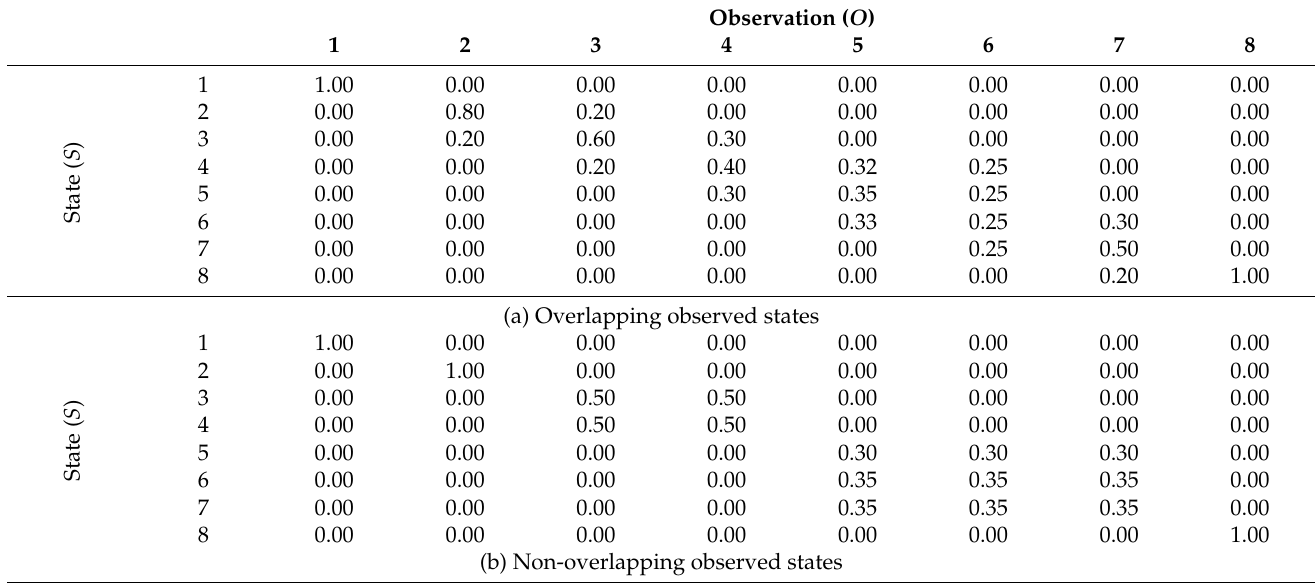
Table 3. Observation probability matrix.